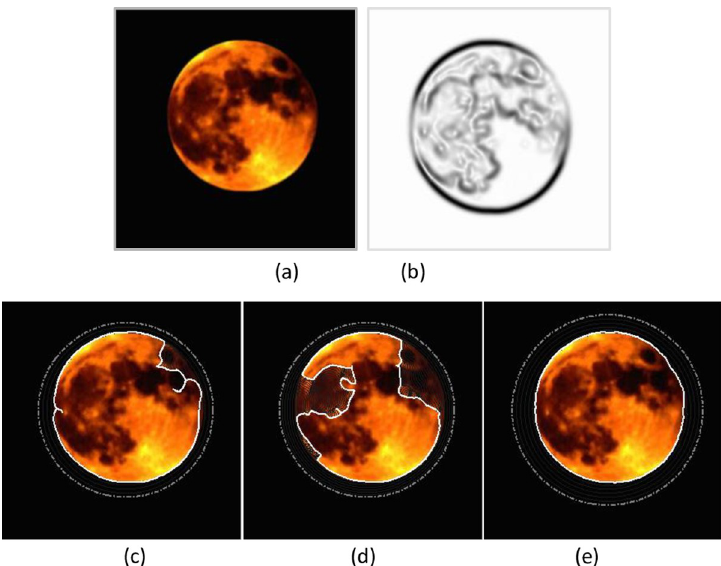
Fig 5. Weak edge preservation example. (a) The moon image,(b) edge map, segmentation results of (c) the GVF snake with μ = 0.05, (d) the VEF snake, and (d) the MCONVEF snake with k = 0.01, h = 0 and L = 10. The gray dash point circles are the initial contours, and the solid lines in white are the converged